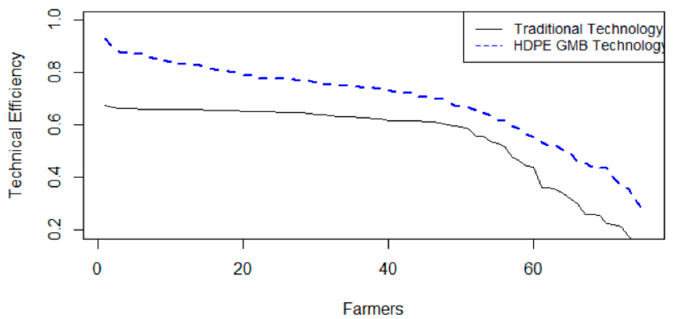
Figure 7. Technical efficiencies for the traditional technology and HDPE GMB technology of sea salt farm production. Source: Own calculation .